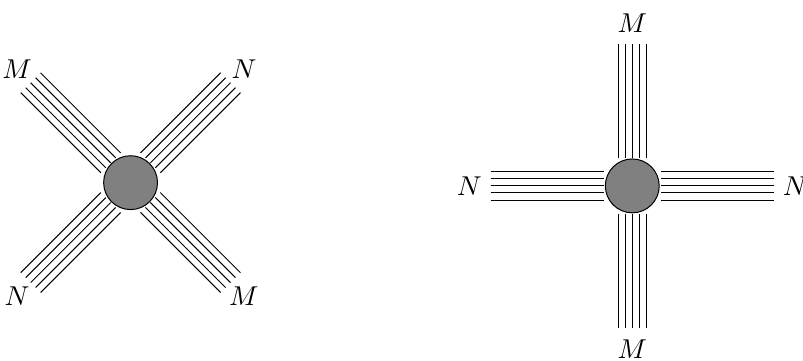
Figure 6 . The left hand side shows the intersection realized in section 4.2. The intersection on the right hand side is related to the one on the left by an SL(2 ; R ) transformation combined with a rescaling of the